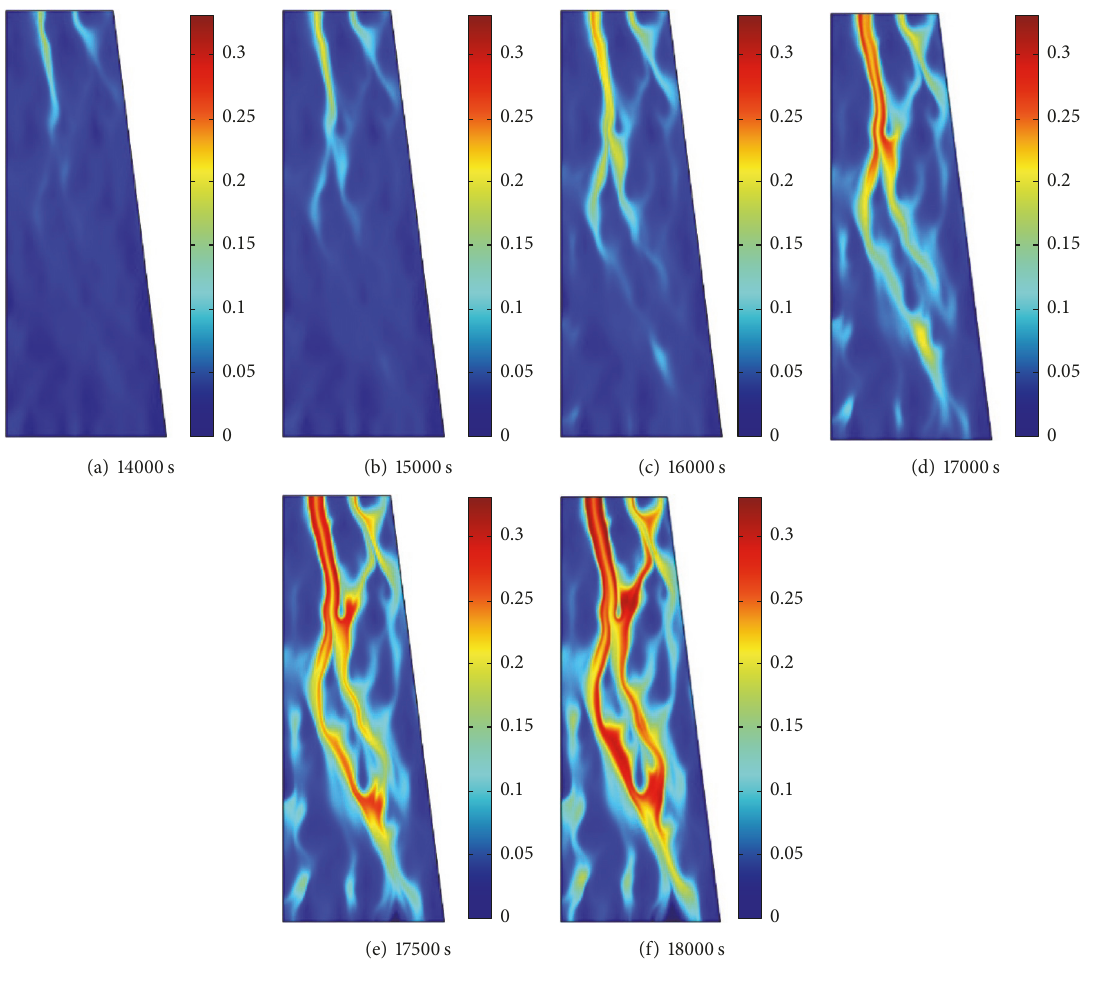
Figure 20: Change of particles concentration in a